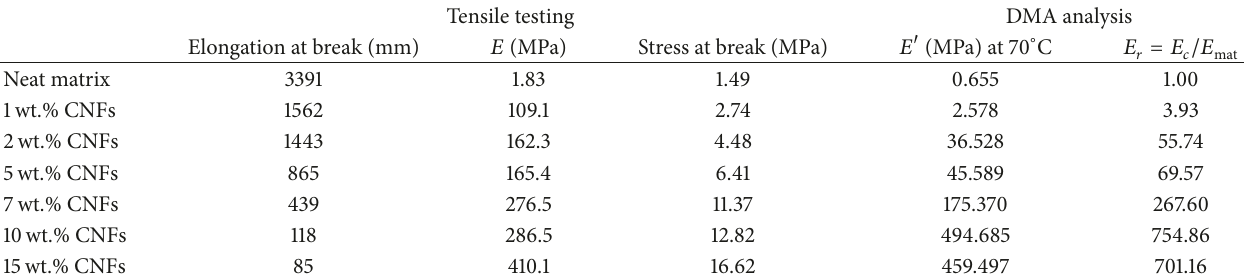
Table 2: Summary of mechanical properties for nanocomposites prepared from Prunus amygdalus CNFs.